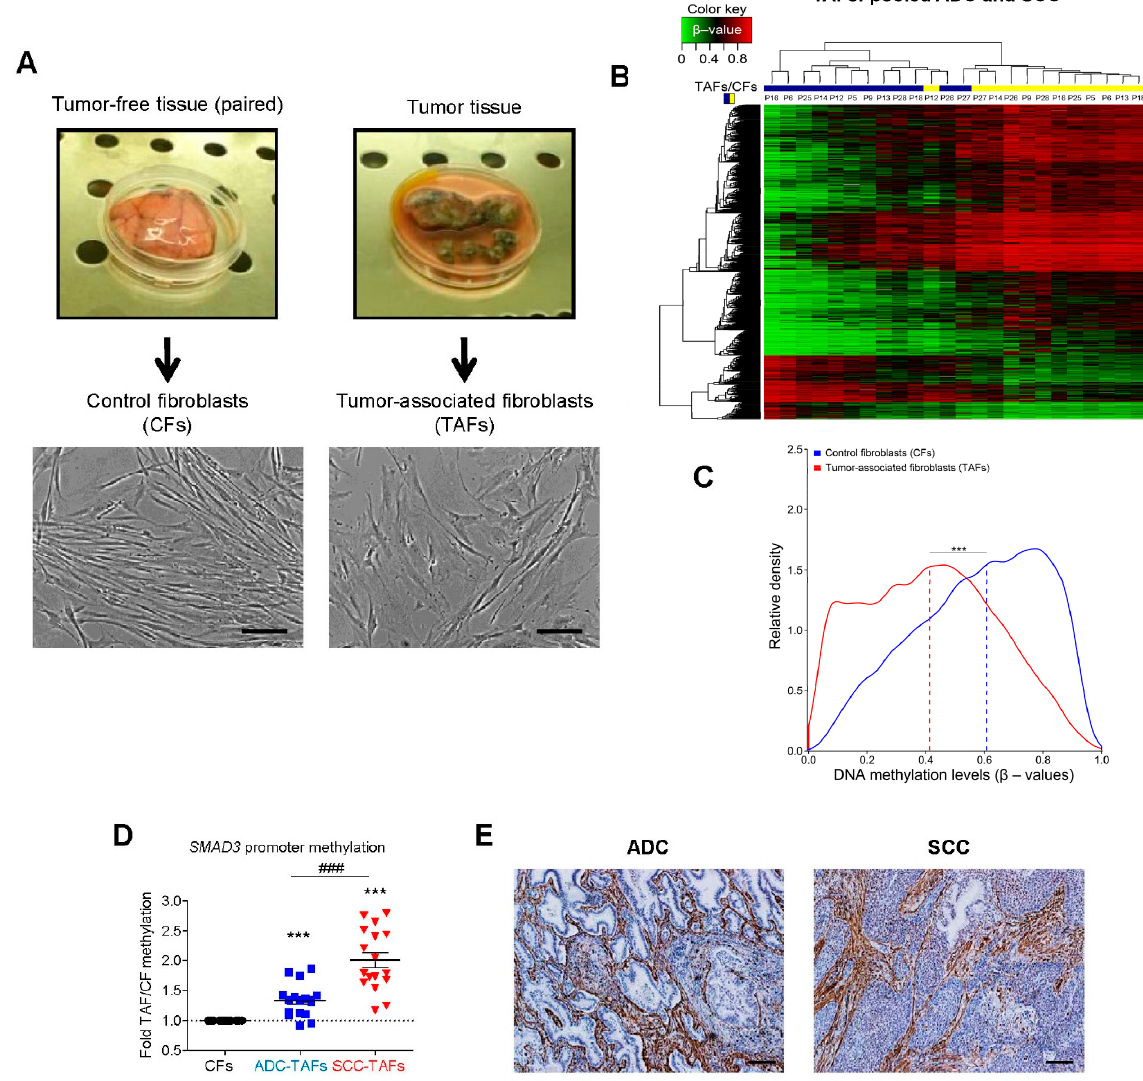
Figure 1. Hallmarks of the epigenetic reprogramming of tumor-associated fibroblasts (TAFs) from lung cancer patients. ( A ) Representative images of a tumor tissue (right) and patient-matched tumor-free pulmonary tissue sample (left) obtained from a surgical lung cancer patient (top row). These tissue samples were used to obtain TAFs and paired control